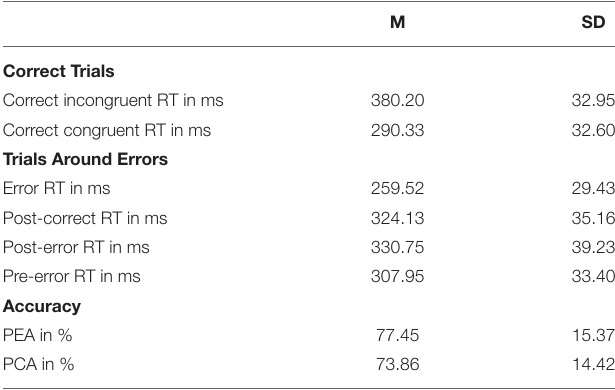
TABLE 2 | Task performance and measures of performance monitoring (means and standard deviations) in the flanker task.